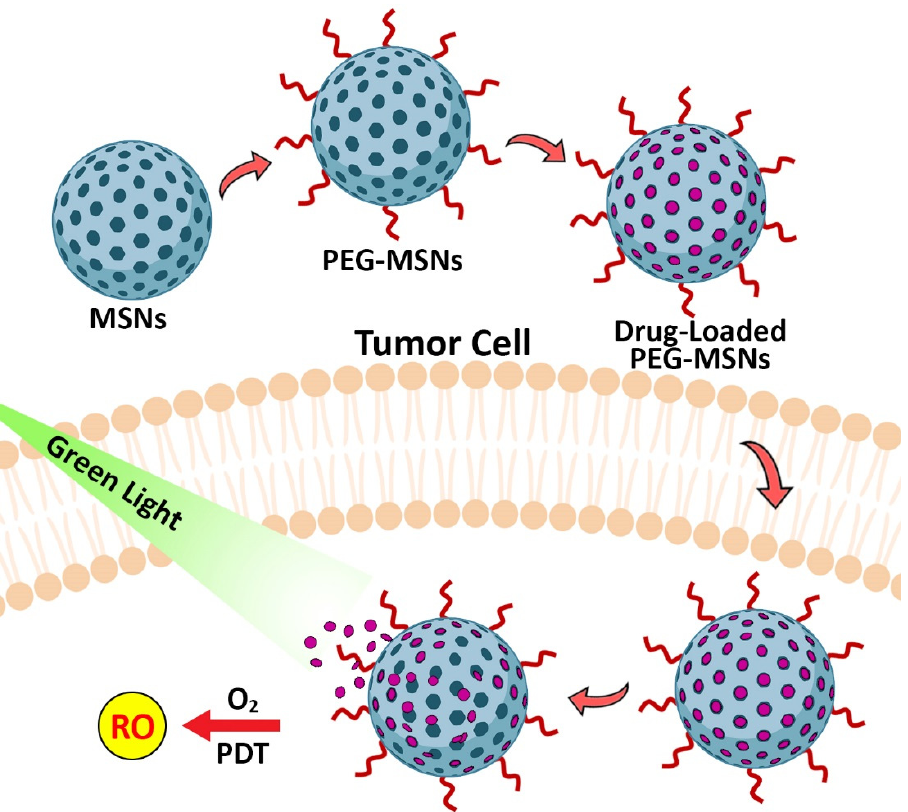
Figure 3. Application of MSNs for photodynamic therapy (PDT) of cancer. The delivery of photosensitizers into tumor cells using PEG-modified MSNs and stimulating the release of photosensitizers by green light irradiation causes the production of reactive oxygen and cancer cell ablation.